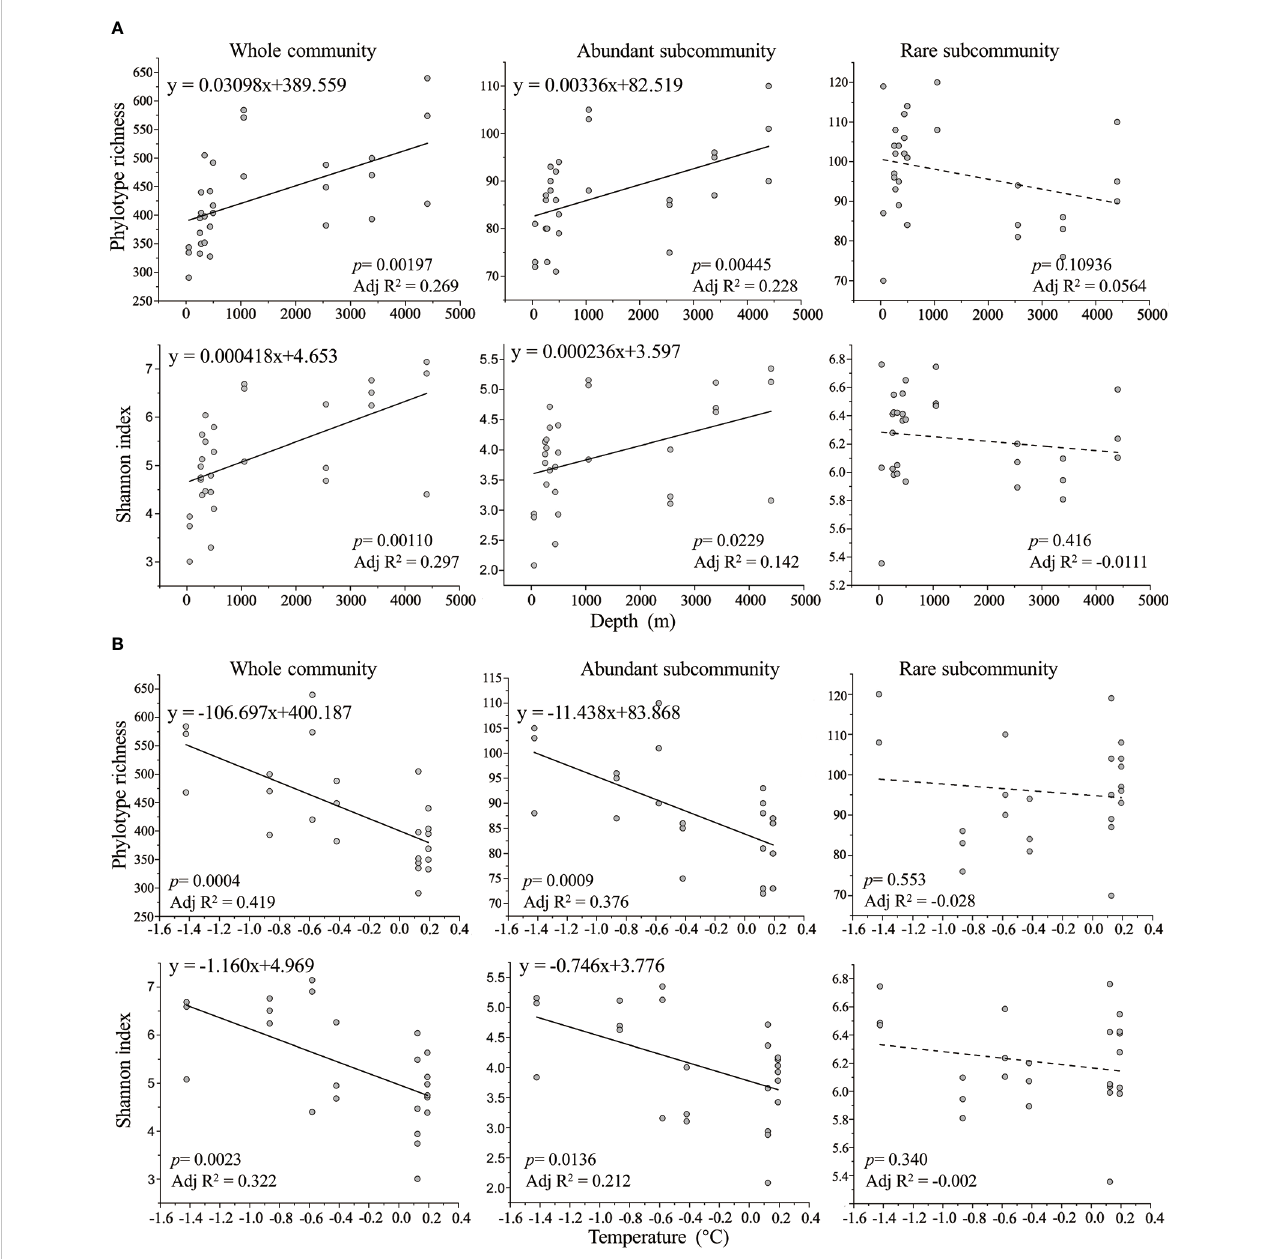
FIGURE 4 The correlations between foraminiferal alpha diversity estimated by phylotype richness and Shannon index and water depth (A) and temperature (B)